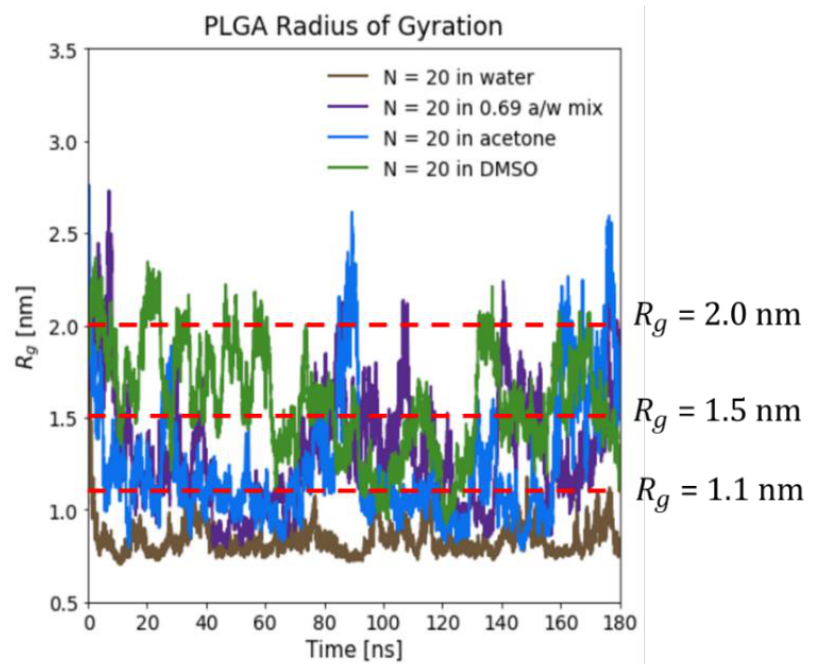
Figure A2. Radius of gyration as a function of simulation time is plotted above for PLGA oligomers at a monomer length of 20 (L c = 10.4 nm) in various solvent conditions encountered during the formulation of PLGA-PEG nanoparticles. The red lines indicate the chosen R g values used in this study, where oligomer R g of 2 nm, 1.5 nm, and 1.1 nm correlate with high, medium, and low levels of extension, respectively.